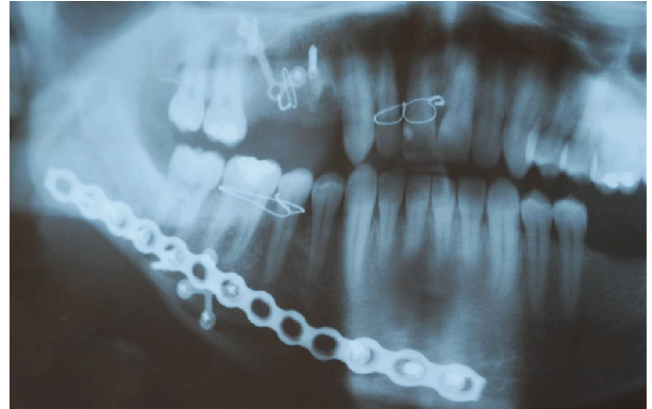
Figure 10: Orthopantomographic radiographic image of titanium plates and screws in position.